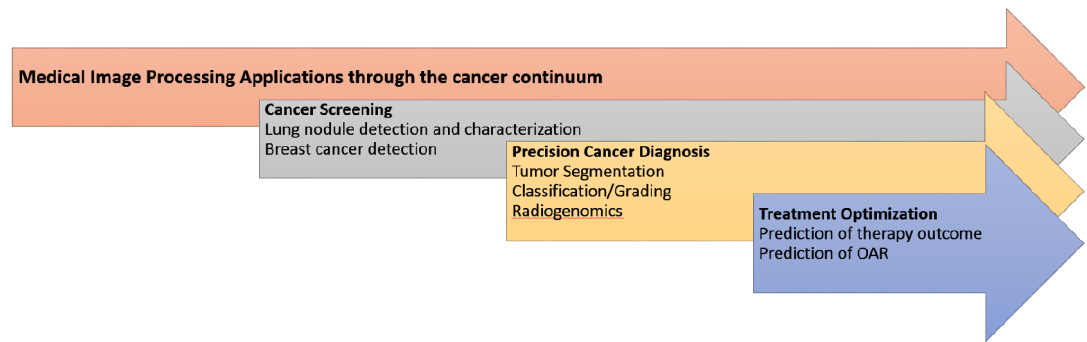
Figure 4. The main medical image processing applications enhanced with AI/radiomics towards precision oncology.